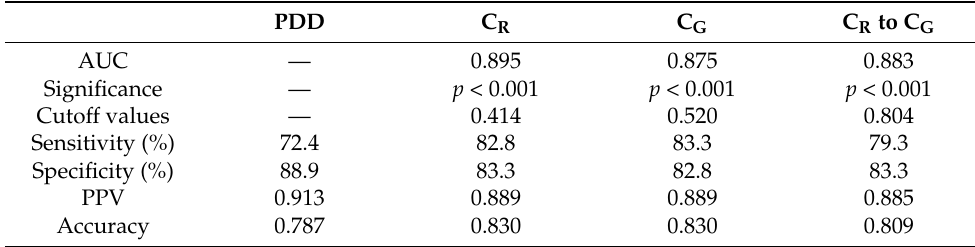
Table 4. Comparison between ALA-PDD and the combination of ALA-PDD and chromaticity analysis for discriminating between high-risk dysplasia and low-risk dysplasia or benign lesions. PDD C R C G C R to C G AUC — 0.895 0.875 0.883 Significance — p < 0.001 p < 0.001 p < 0.001 Cutoff values — 0.414 0.520